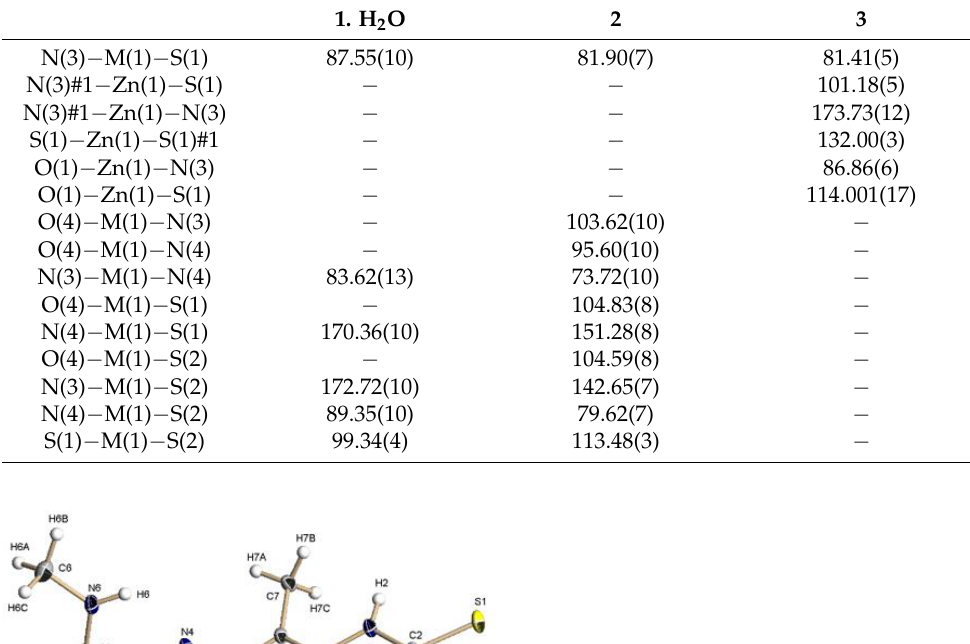
Table 3. Selected bond angles ( o ) for complexes 1. H 2 O, 2 and 3. 1. H 2 O